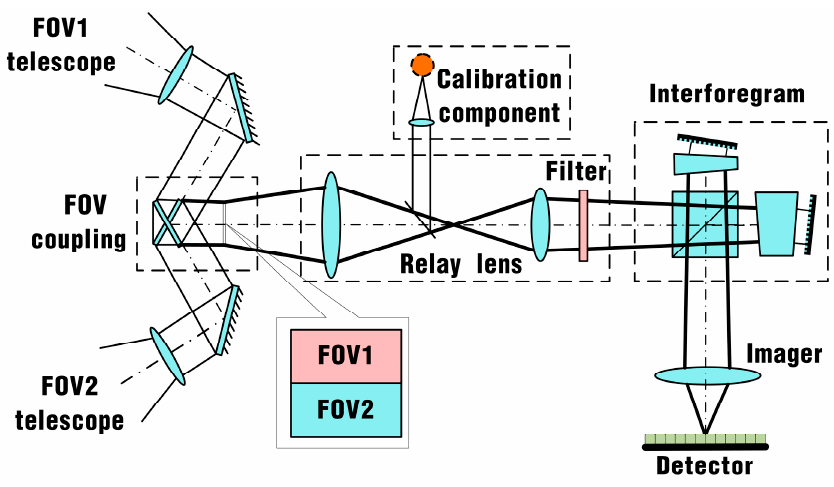
Figure 6. Schematic diagram of the Mesosphere Wind Image Interferometer (MWII). Airglow signals from the orthogonal directions enter the MWII through two tele-